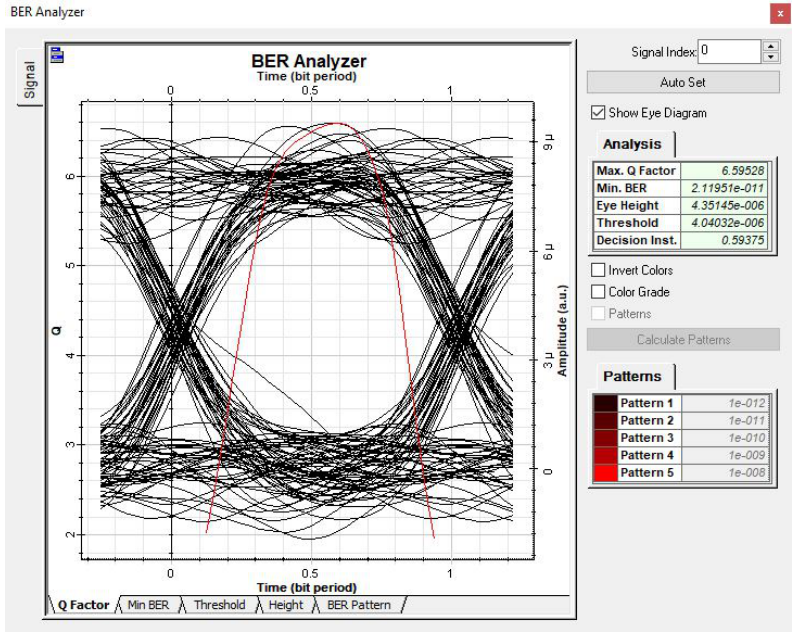
Figure A3. Receiver 1 eye pattern for 60 km